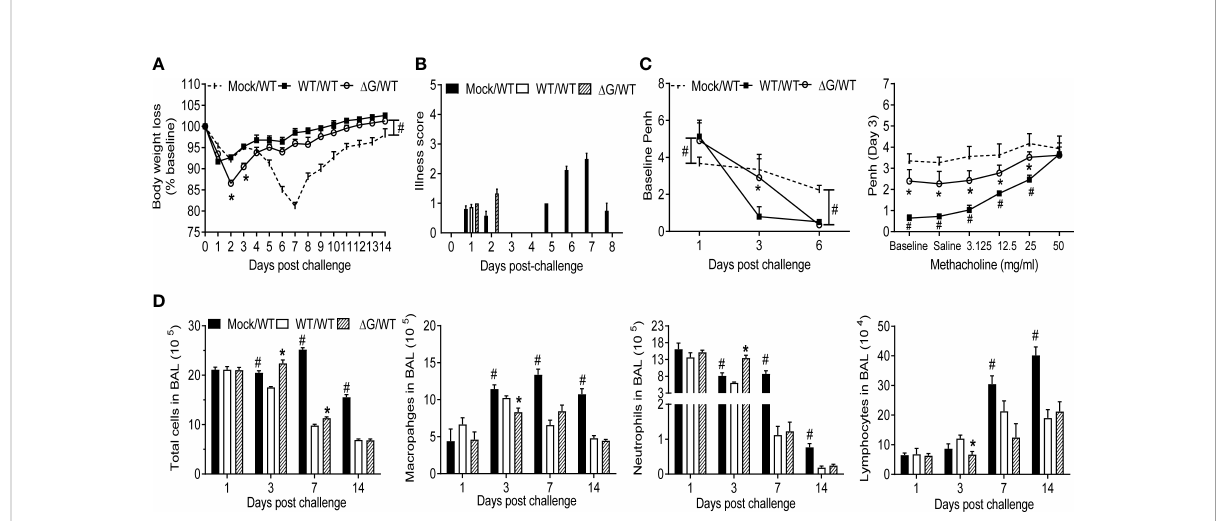
FIGURE 7 Clinical disease, cellular immune responses in response to virus challenge. Mock and with rhMPV-WT or - D G infected mice were challenged with rhMPV -WT virus 6 weeks after primary infection and sacri fi ced at various time points p.i. to collect BAL fl uid. Change in body weight (A) and illness score (B) were measured over a period of 14 days. Data are expressed as mean ± SEM of four animals/group and the fi gure represents cumulative data from two independent experiments. (C) Penh values were measured at baseline (airway obstruction) and post- methacholine challenge by unrestrained plethysmography. Data are expressed as mean ± SEM of four animals/group and is representative of one of two independent experiments. (D) BAL fl uid was subjected to cytospin and analyzed for total and differential cell counts. *P<0.05 when comparing rhMPV -WT and - D G mice challenged with rhMPV -WT.; # P<0.05 when comparing rhMPV (-WT and - D G) challenged with rhMPV -WT and mock- mice challenged with rhMPV -WT. Mock/rhMPV -WT = Mock/WT; rhMPV - D G/rhMPV – WT = D G/WT; rhMPV -WT/rhMPV -WT =